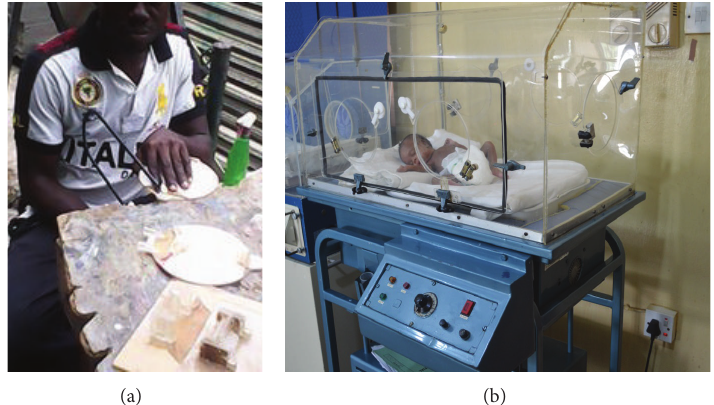
Figure 5: Localised spare parts fabrication. (a) An artisan working on Perspex items of incubator spare part in his private workshop. (b) Locally fabricated incubator in use at FMC